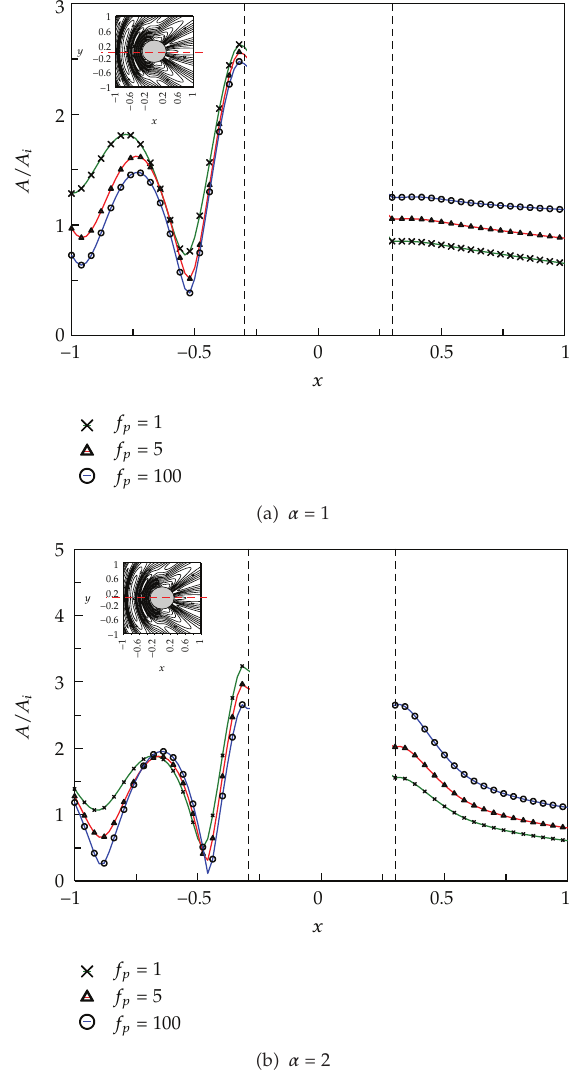
Figure 3: E ff ects of linearized friction coe ffi cient (cid:2) ρ 0 (cid:4) 0 . 2 π , ρ 1 (cid:4) 0 . 1 π , n 0 (cid:4) 0 . 5 (cid:3)